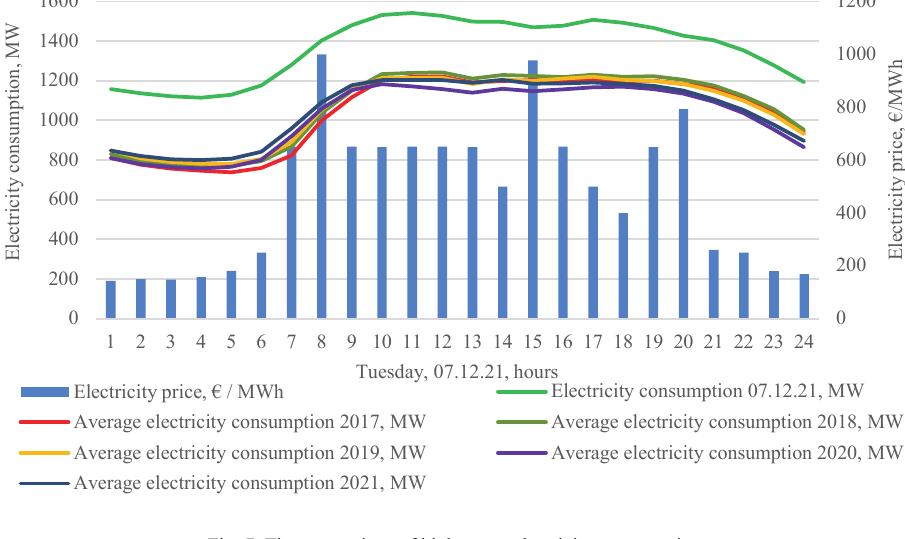
Fig. 7. The comparison of high – cost electricity